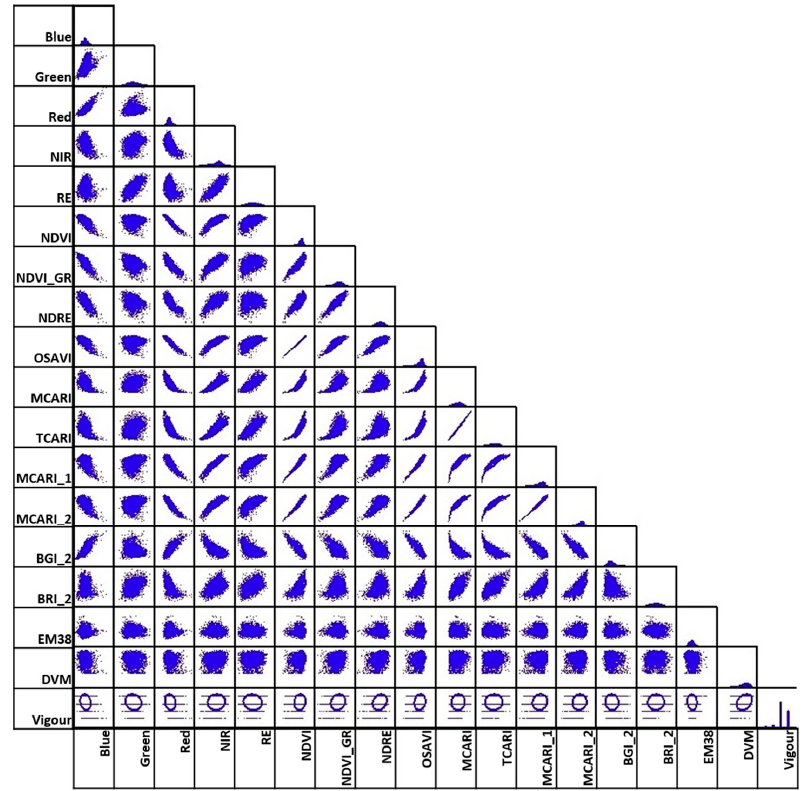
Figure 16. Scatter plot of correlation for data presented in Figure 15, generated from multispectral imagery in February 2017.